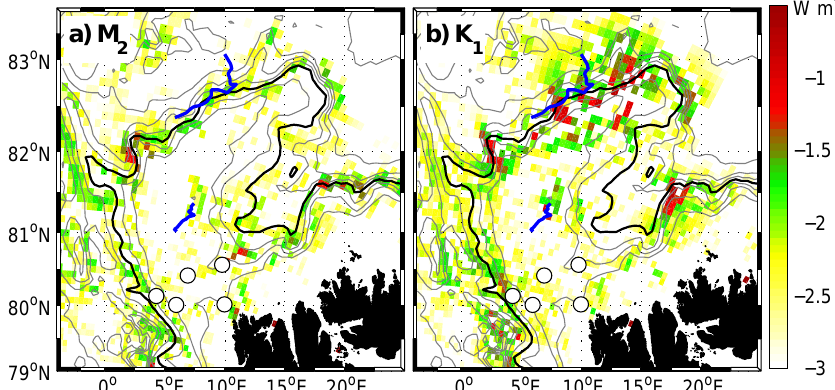
Figure 7. Depth-integrated dissipation rate, presented in base-10 logarithm, for the (a) M 2 and (b) K 1 constituents obtained from STORMTIDE. Isobaths (grey) drawn at 500m intervals are from the model topography. The 2000m isobath is drawn in black for refer- ence. Station positions (open circles) and the drift of CEAREX-O (Padman and Dillon, 1991) and MIZEX83 (D’Asaro and Morison, 1992) are also shown. Table 5. Volume-integrated conversion and radiation rates for the M 2 and K 1 constituents, bounded by selected isobaths. Shallower than 250m (not listed), there is approximately 10MW conversion, for both M 2 and K 1 , balanced by local dissipation. M 2 M 2 M 2 K 1 K 1 K 1 Isobath Conversion Radiation Dissipation Conversion